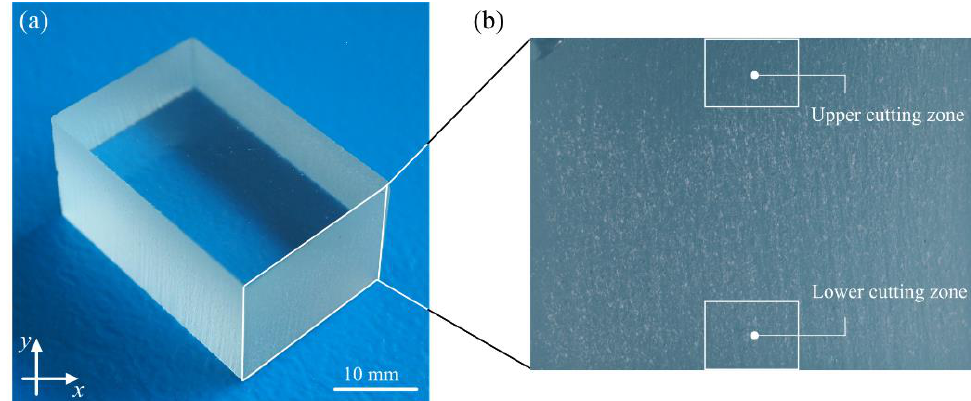
Figure 1. Glass workpiece after abrasive water jet cutting process: ( a ) general view of the glass workpiece; ( b ) a section of the glass workpiece with the upper and lower cutting zone marked.